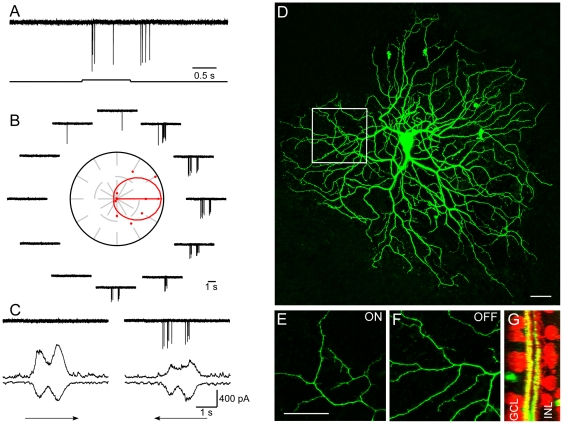
A DSGC in the retina treated with Epb for 15 days.A: To a stationary flashing spot, the cell responded to both the onset and termination. B: To a rectangle moving in 12 directions, highly asymmetrical responses could be observed. Polar plot shown in the middle of response traces with the vector sum represented by the arrow and the tuning curve by the circle. C: Excitatory and inhibitory synaptic inputs recorded when membrane potential was held at −65 mV and 0 mV, respectively. D: Dendritic morphology of the recorded cell. E–G: High magnification of the region indicated by the white square in D. E and F: Showing dendrites in the ON and OFF sublamina, respectively. G: Side view, showing costratification with ChAT bands. Scale bar: 30 µm.